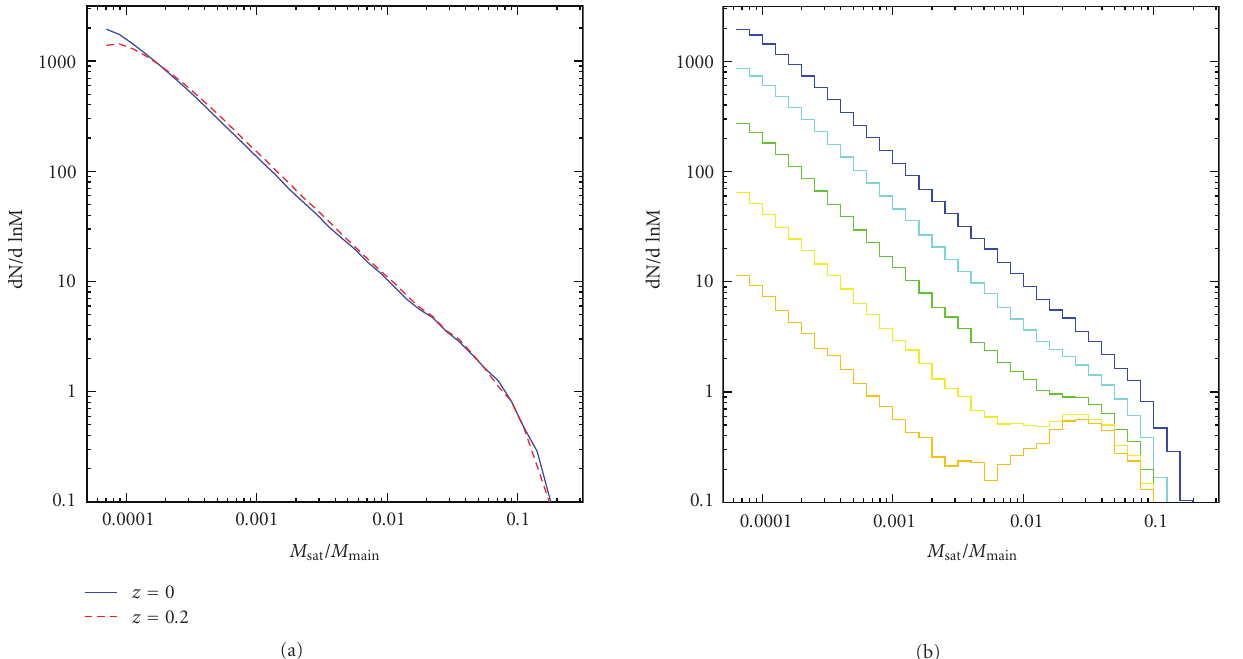
Figure 2: (a) The average di ff erential mass function of subhalos within the virial radius for halos at redshift z = 0 (solid blue line) and z = 0 . 2 (dashed red line). (b) The average di ff erential mass function for halos at radii less than 1.0, 0.5, 0.25, 0.125, and 0.0625 times the virial radius (di ff erent histograms, from top to bottom). The excess of massive systems at small radii is clearly visible.